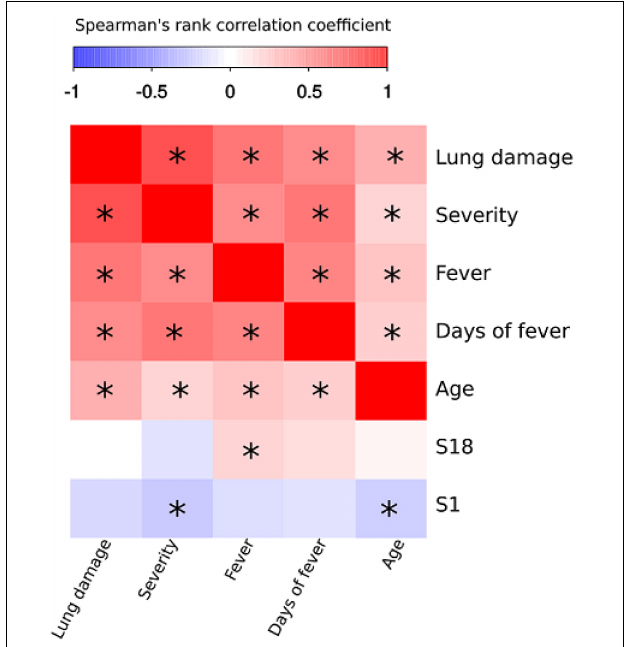
FIGURE 6 | Correlation analysis of SARS-CoV-2 peptide antibody reactivity with clinical and demographic features of COVID-19. Spearman’s rank test was used to analyze correlation between reactivity with SARS-CoV-2 peptides and clinical presentation and characteristics of patients. Asterisks indicate statistically significant correlations ( p < 0.05 with Benjamini-Hochberg